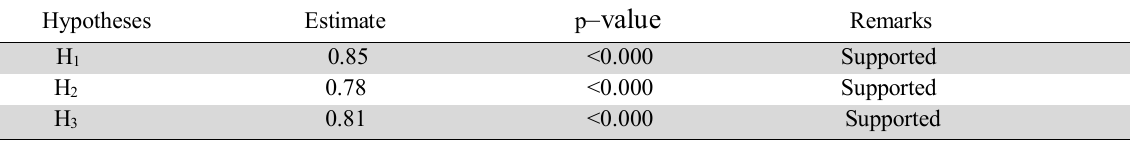
Standardized path